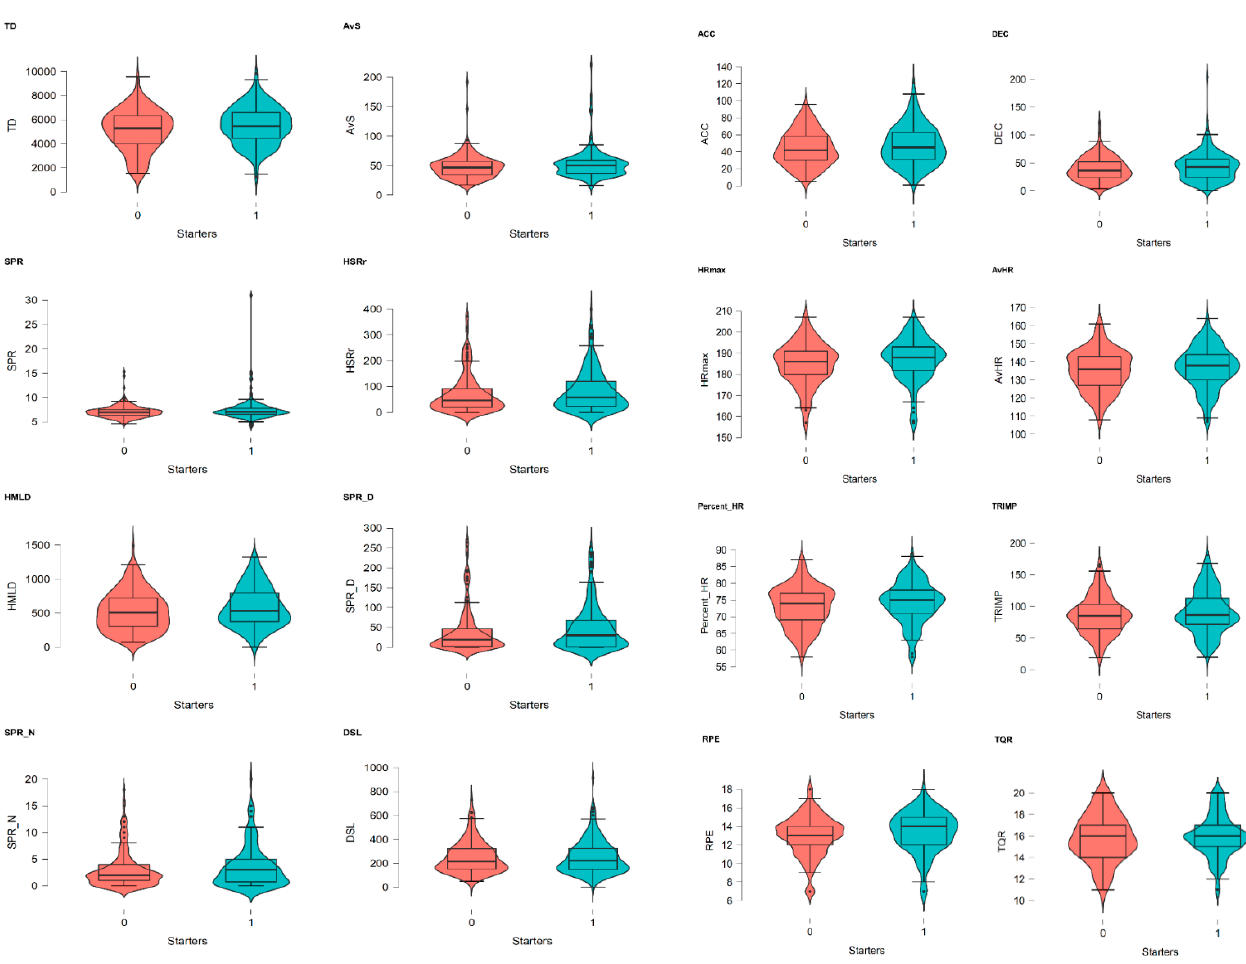
Figure 1. Comparison between starters and non-starters for each training load measure. Note: “Starters” coded 1 (red graph) and “non-starters” coded 2 (green graph).